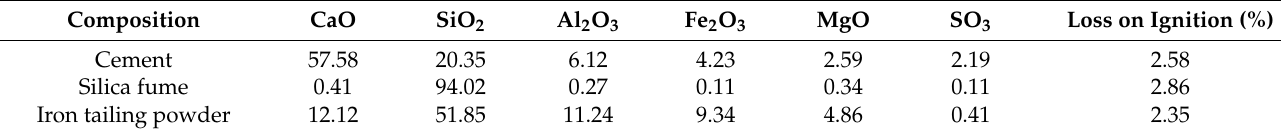
Table 2. Chemical composition of cementitious materials (wt.%).